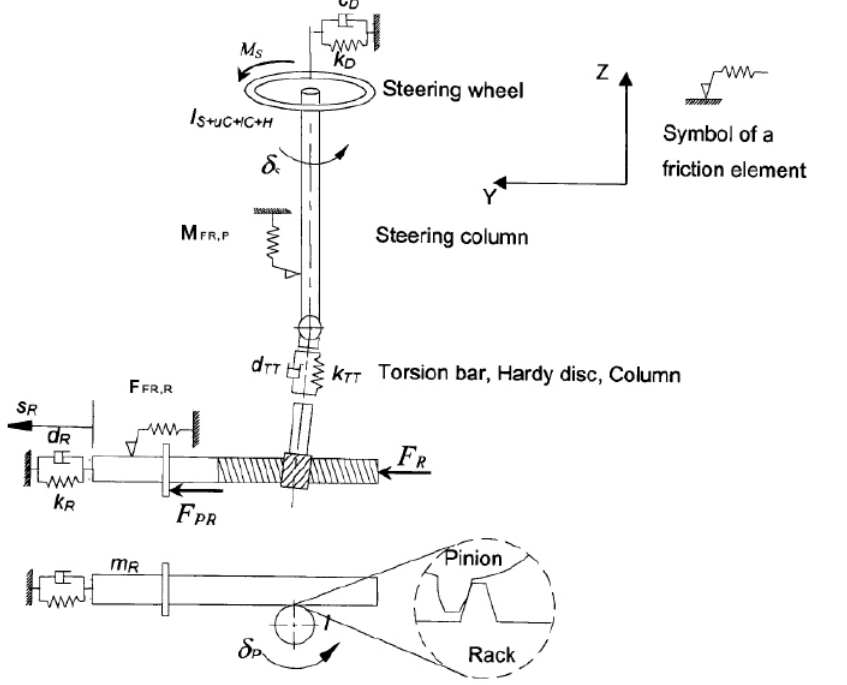
Figure 2. 2-DOF steering model. Reprinted/adapted with permission from Ref. [20]. 2006, Peter